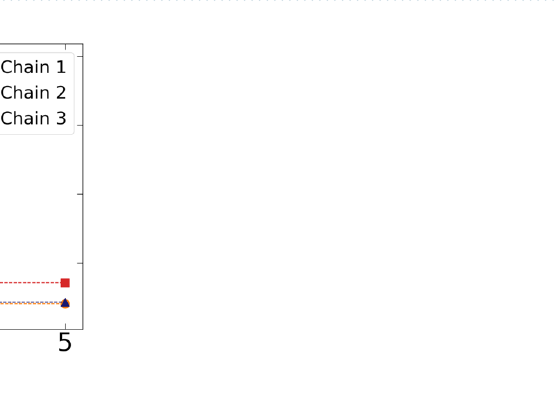
α R transition of alanine dipeptide obtained from our Monte Figure 4. ( a ) Transition pathways for the C 5 → Carlo scheme. The red line denotes the first (top) and last (bottom) trajectory in a Markov chain. The points in the Ramachandran plots are obtained from projecting the configurations generated with iMapD. In the background is the free energy surface calculated from 1 μs of plain MD. ( b ) Transition path density on the Ramachandran plane, evaluated for the ensemble of trajectories calculated with our Monte Carlo scheme. The solid orange line is the most probable path, obtained using the Dijkstra algorithm 59 on a classical computer.